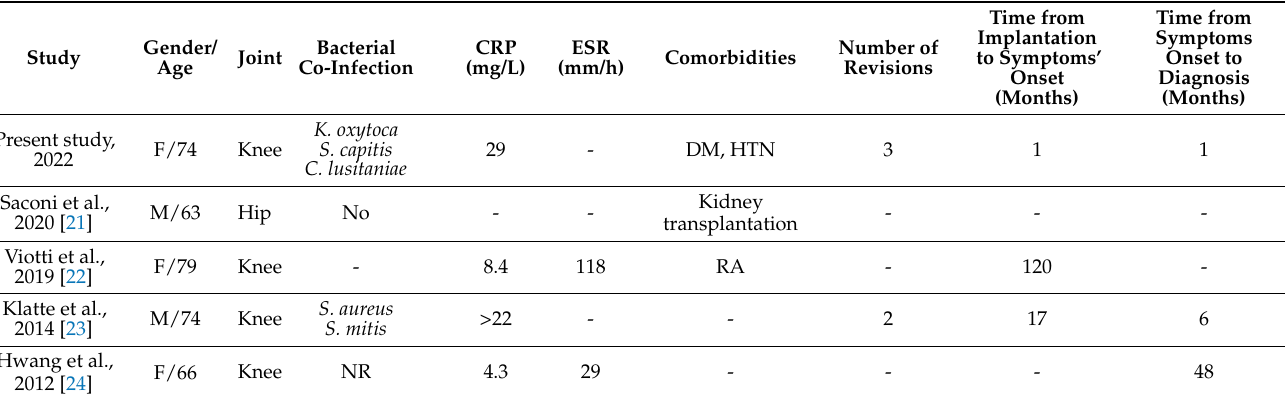
Table 1. Summary of included